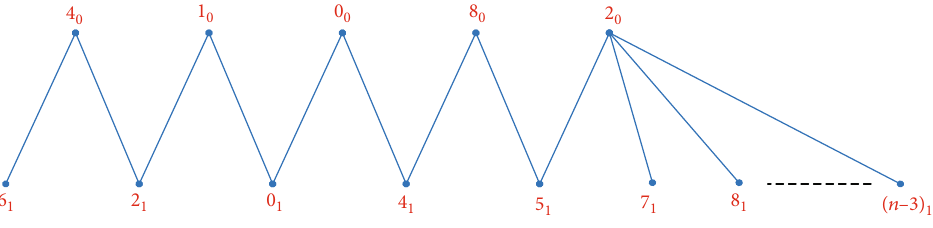
Figure 22: An orthogonal labeling for C